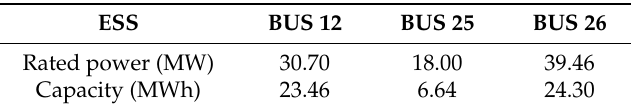
Table 4. Optimal allocation of energy storage systems